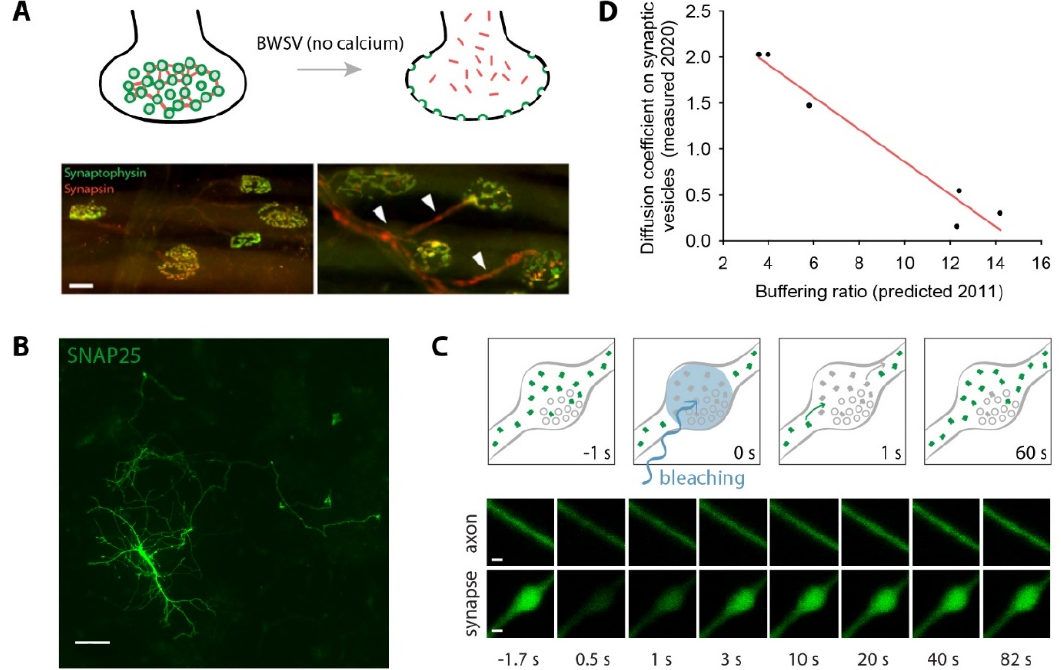
Figure 6. Estimates of protein mobility in synapses, from different technologies. ( A ), Synaptic vesicle clusters were disrupted by application of black widow spider venom (BWSV) on freshly dissected neuromuscular synapses. As the vesicles (green, marked by synaptophysin) are lost by exocytosis not compensated by endocytosis, the soluble proteins diffuse out of the boutons (red; synapsin is shown in the example, showcased by the arrowheads in the right panel, corresponding to the BWSV application). Scale bar: 20 µm. Reproduced from [30]. ( B ), Synaptic proteins were expressed in cultured hippocampal neurons (green). Scale bar: 100 µm. ( C ), This was followed by a fluorescence recovery after photobleaching (FRAP) procedure, in which synapses or axonal areas were bleached, and the movement of proteins within the bleached areas was estimated. Scale bar: 500 nm. ( B ) and ( C ) reproduced from [33]. ( D ), Both technologies produced estimates of protein binding to vesicles, either as protein buffering ratios (X axis, from neuromuscular synapses), or as diffusion coefficients in the vesicle cluster (Y axis, from hippocampal synapses). The two measurements correlate well for the six common proteins investigated (R 2 0.95, p < 0.001).